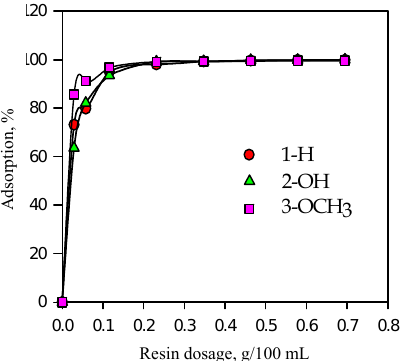
Figure 2 . Effect of resin (Dowex 50WEX/H + ) dosage on the adsorption % of the studied organic cations at 30 o